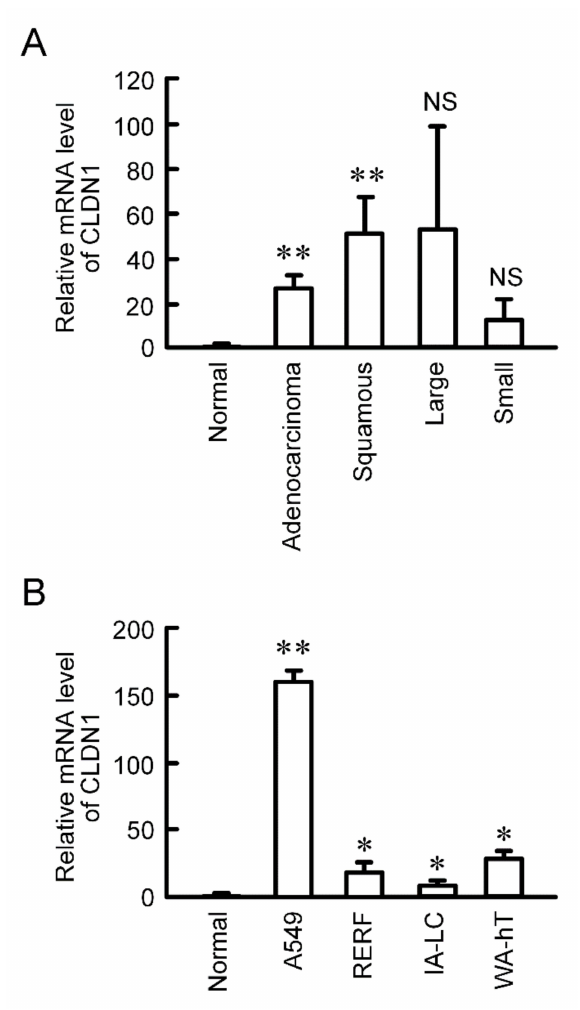
Figure 1. Elevation of CLDN1 mRNA in human lung cancer tissues and cell lines. ( A ) cDNA